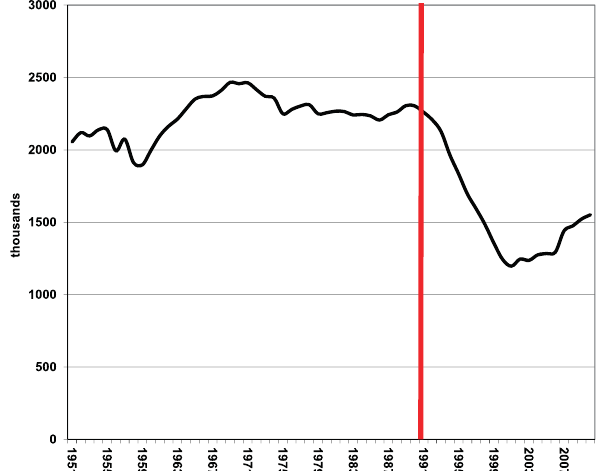
Fig. 1. The population of domesticated reindeer in Russia from 1951 to 2010, in thousands. The vertical line represents the date of the USSR’s collapse in 1991. After a decline in the first decade following the end of the Soviet period culminat- ing in a minimum number of 119 700 in 2001, the number of reindeer started to